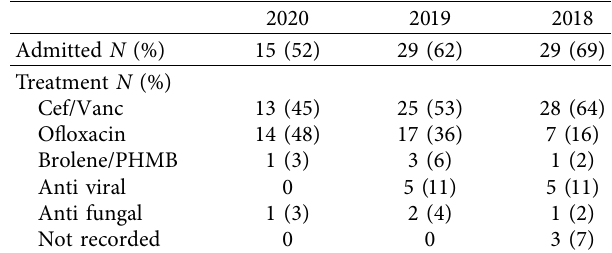
Table 2: Clinical details.